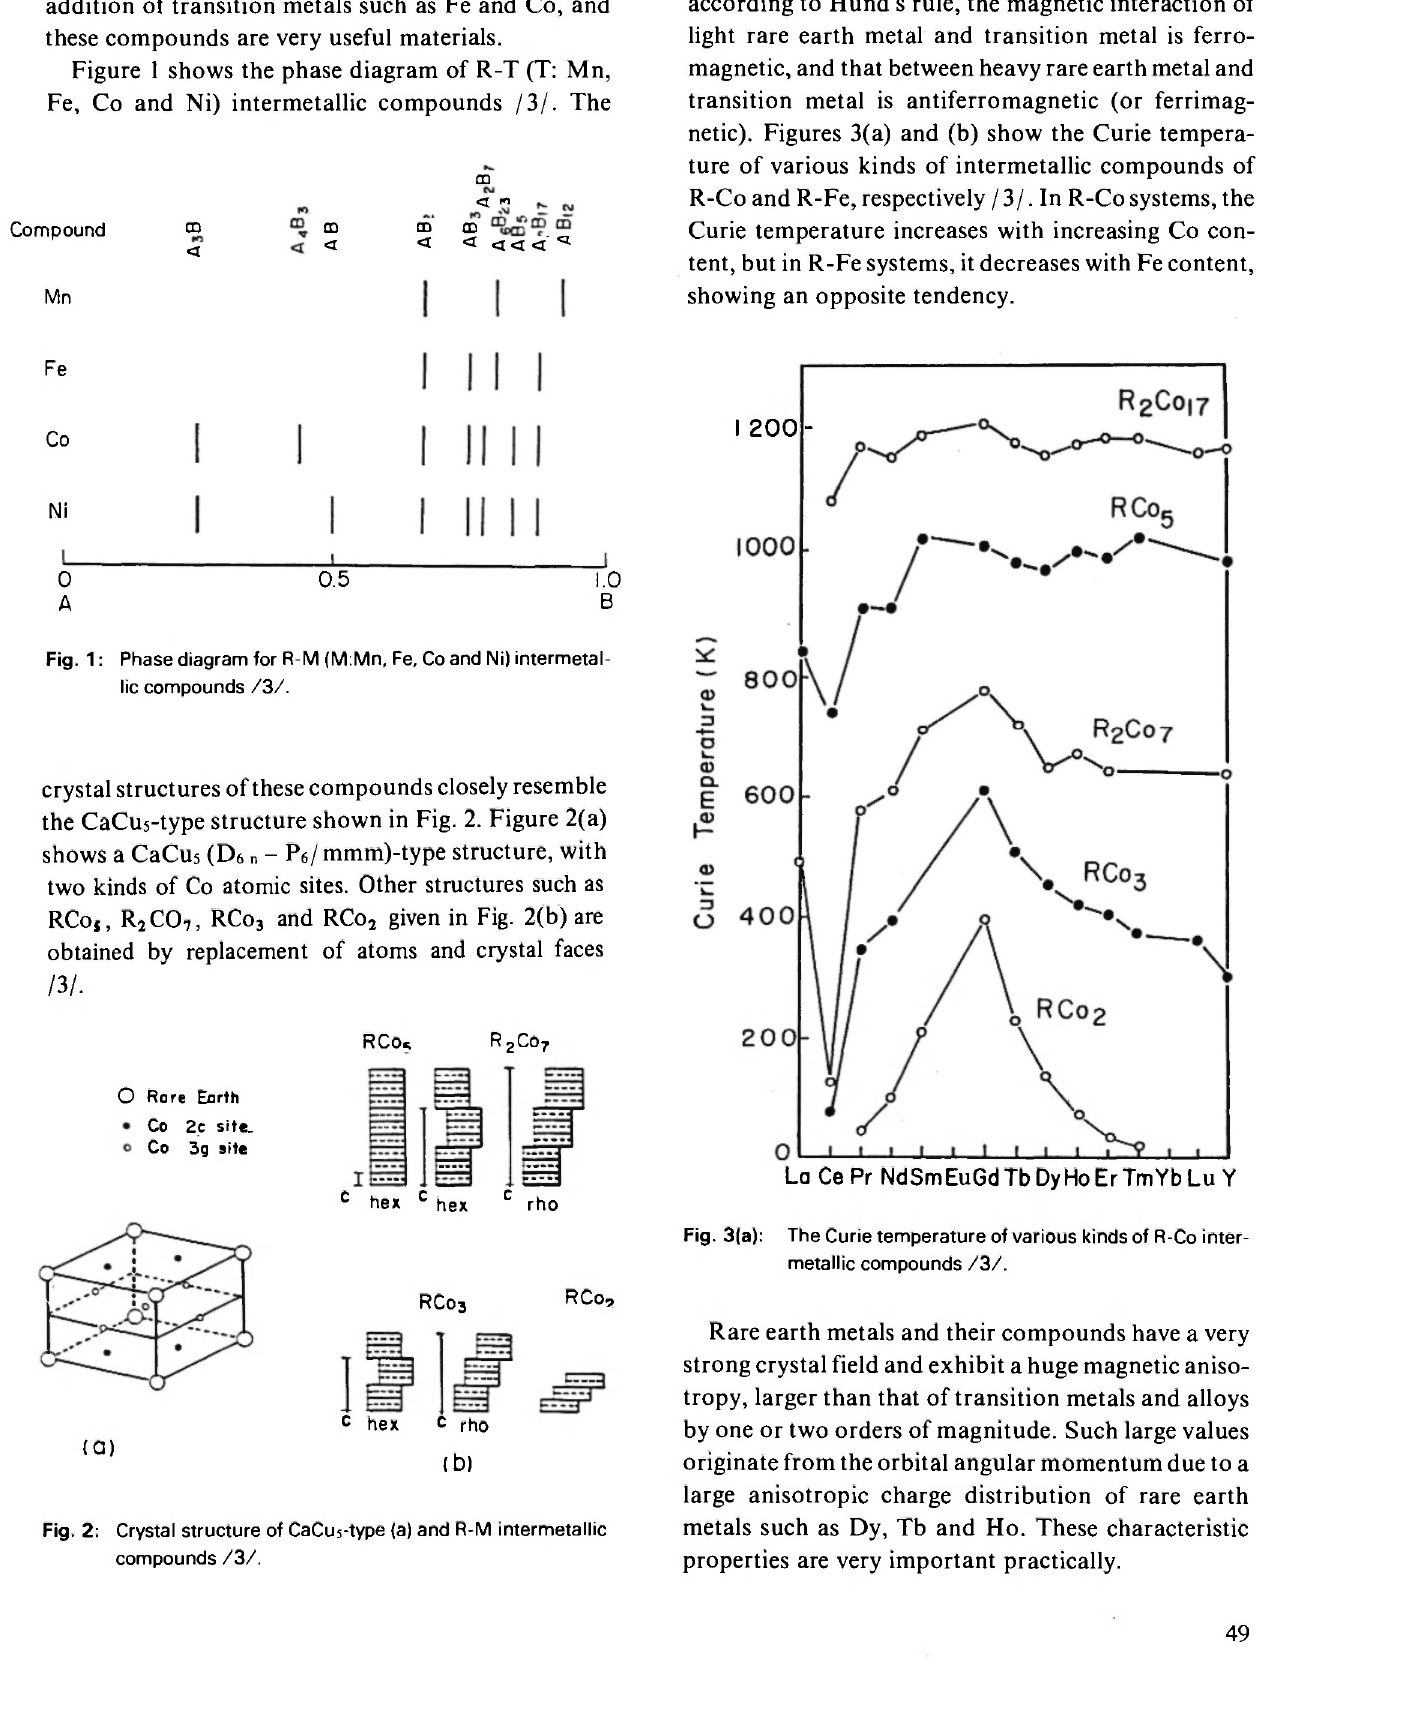
Fig. 2: Crystal structure of CaCu 5 -type (a) and R-M intermetallic compounds /3/.